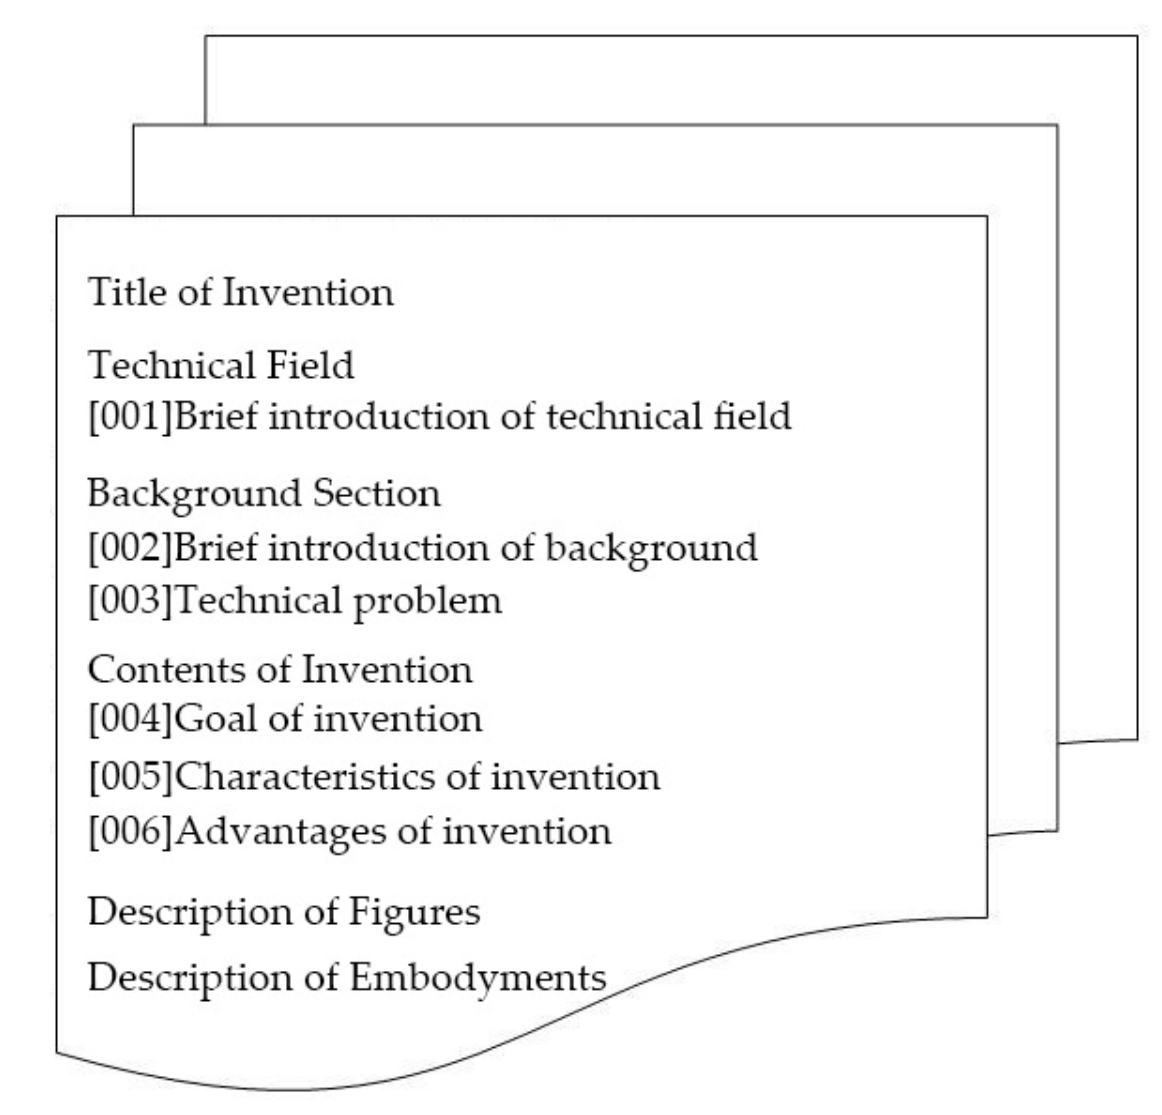
Figure 3. Structure of the description section of a Chinese invention.